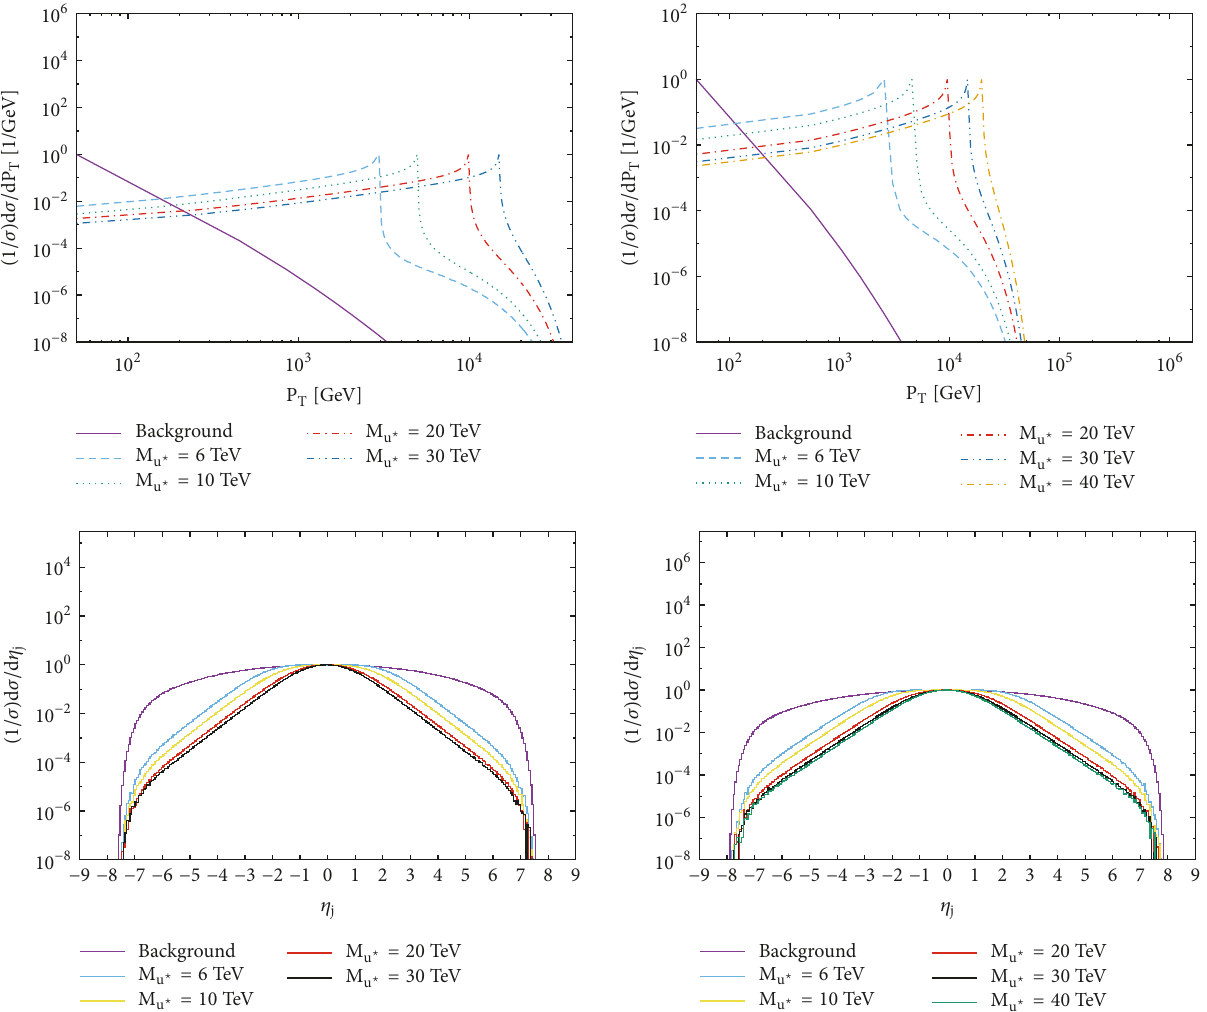
Figure 4: Transverse momentum and 𝜂 distribution plots for FCC (left column) and SppC (right